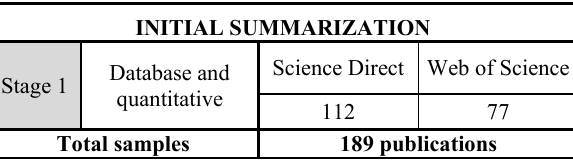
Table 1: Inicial summarization, Stage I.